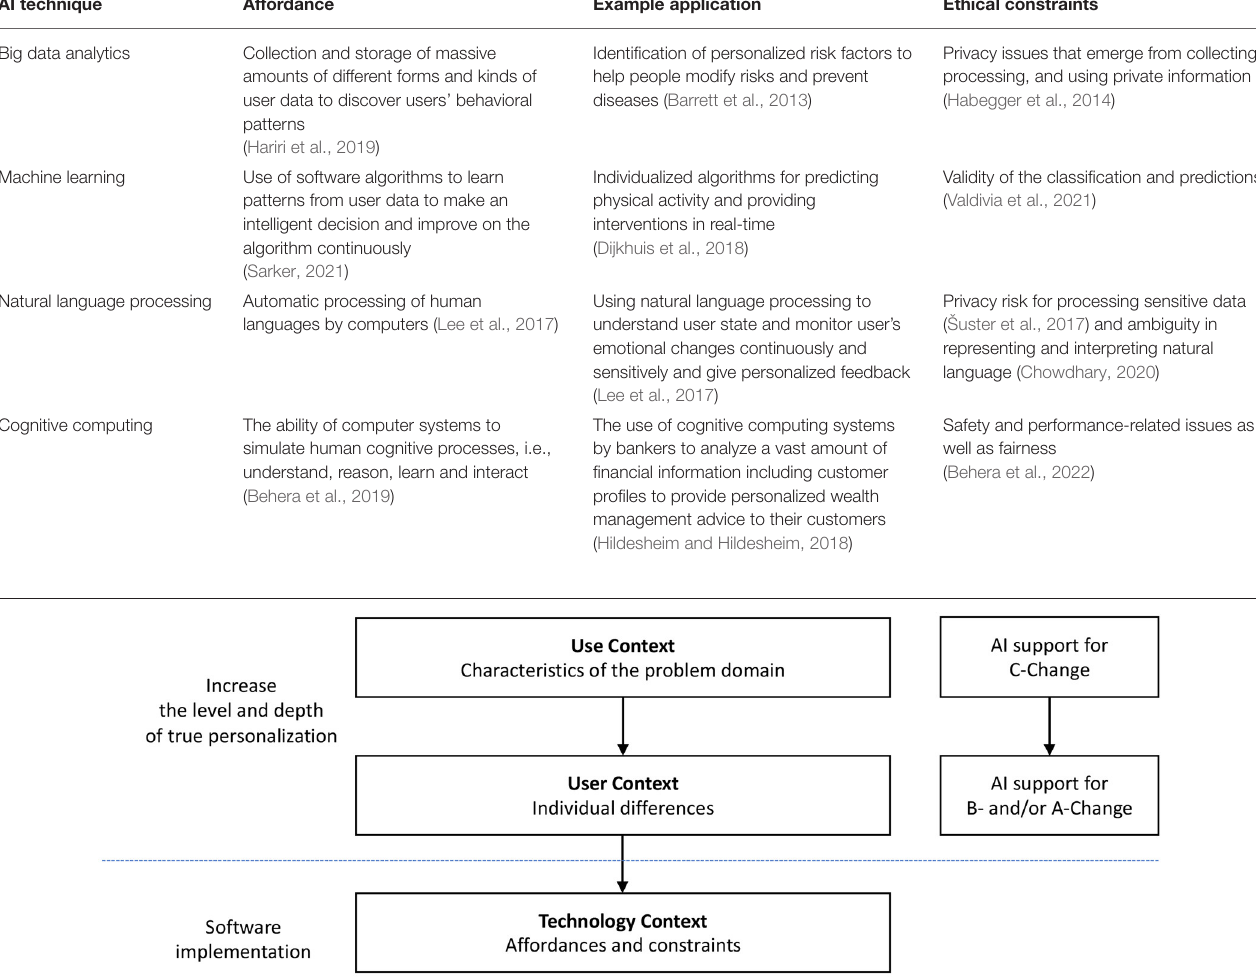
TABLE 4 | AI techniques, affordances, example application and ethical constraints.